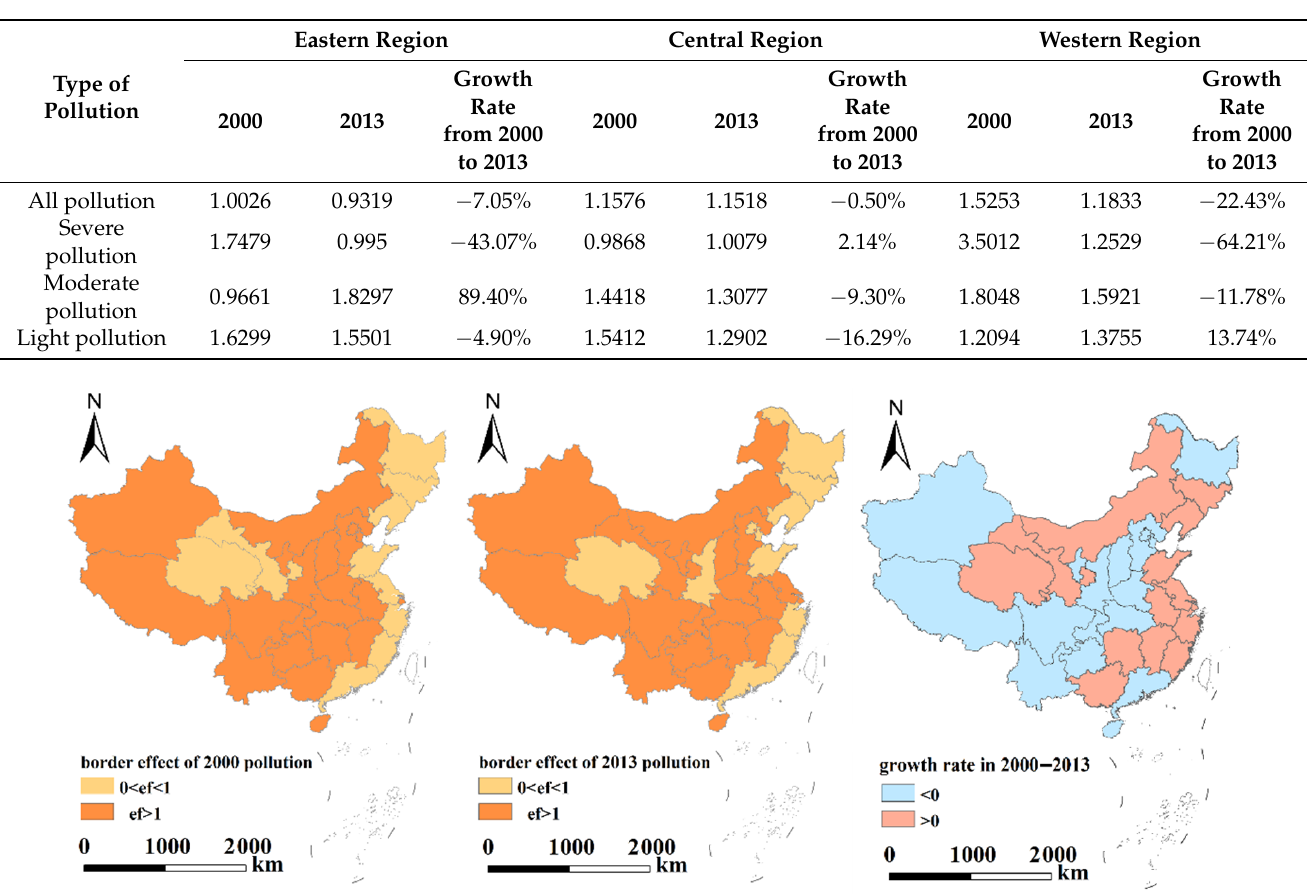
Figure 3. Transboundary pollution effects at the provincial level (three types of polluting enter- prises).